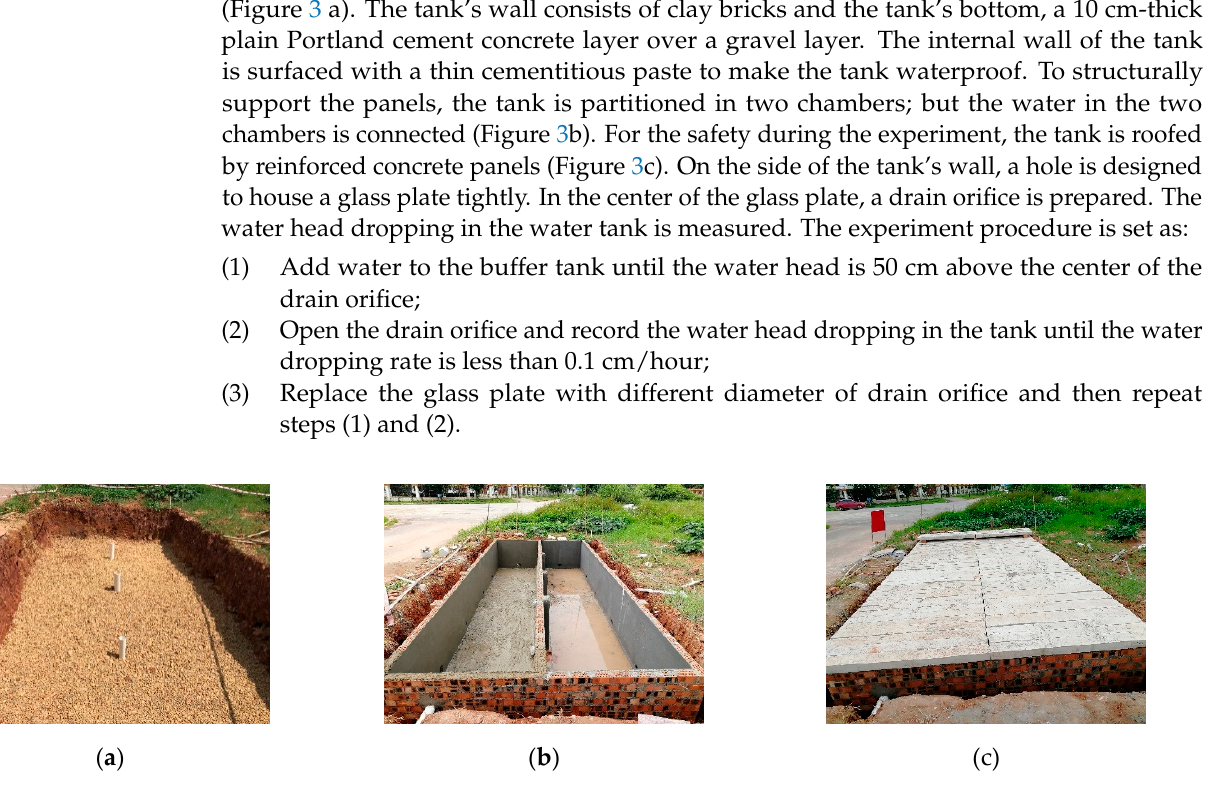
Figure 3. Schematic diagram of the buffer tank. ( a ) Pit excavation for the tank; ( b ) construction of the buffer tank. ( c ) The buffer tank with reinforced roof.